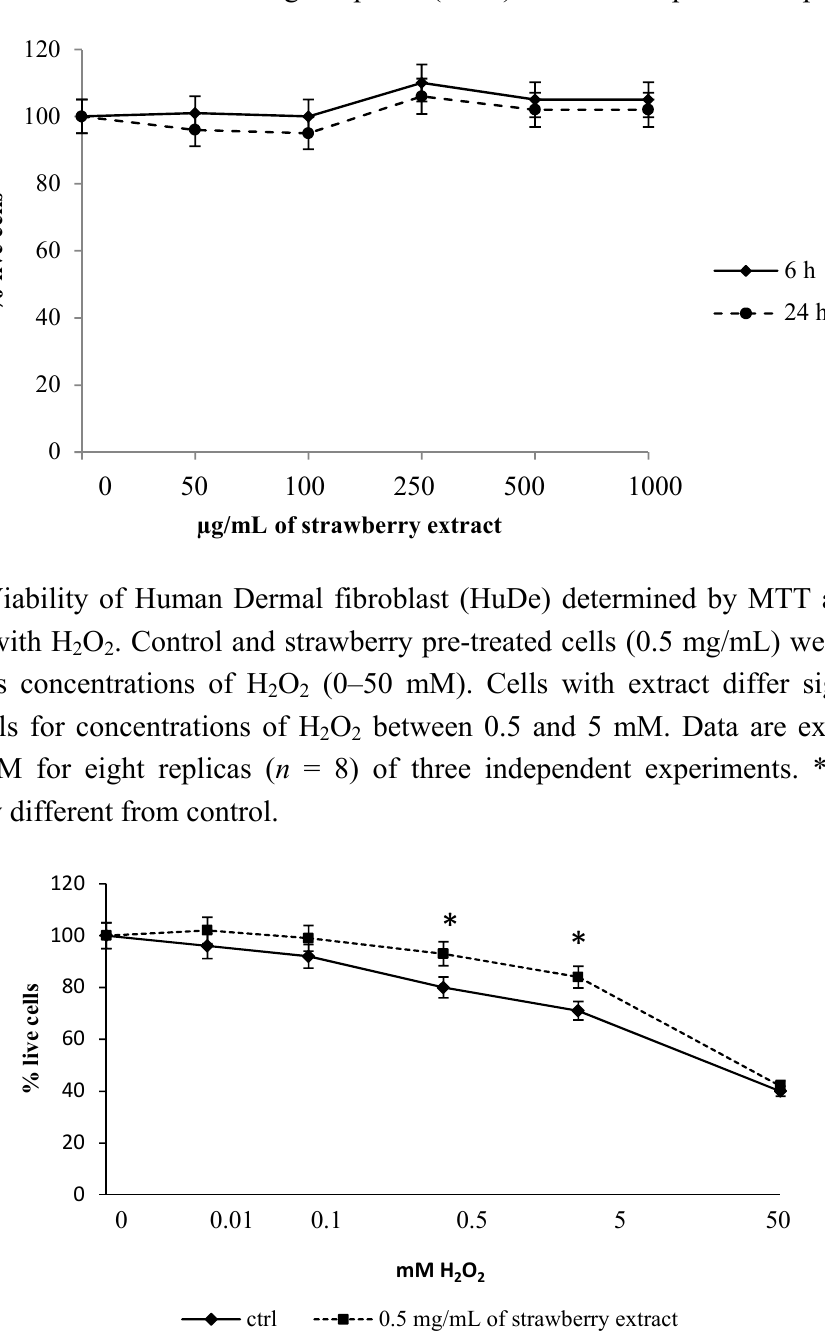
Figure 1. Viability of Human Dermal fibroblast (HuDe) determined by MTT assay after incubation with different concentrations of strawberry extract and at different times. Data are expressed as mean ± SEM for eight replicas ( n = 8) of three independent experiments.